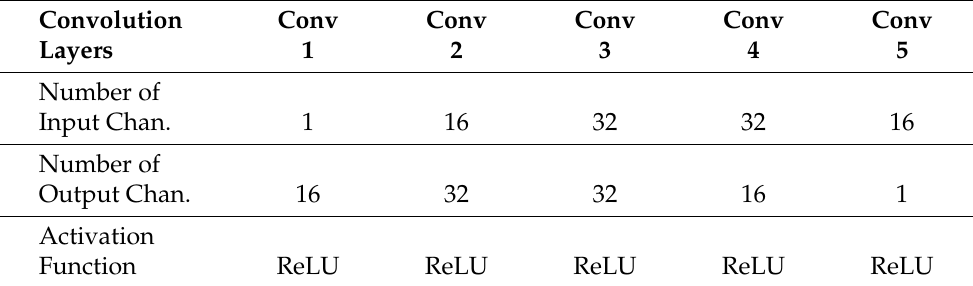
Table 2. Details of the convolution layers of the AE.